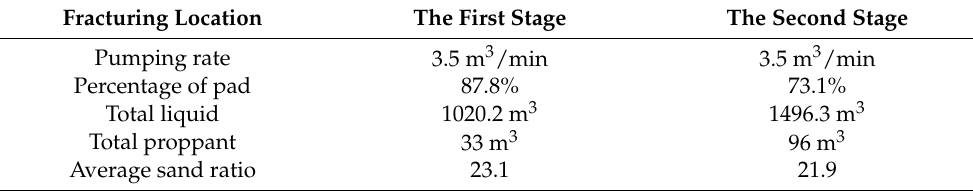
Table 3. Summary of construction parameters.